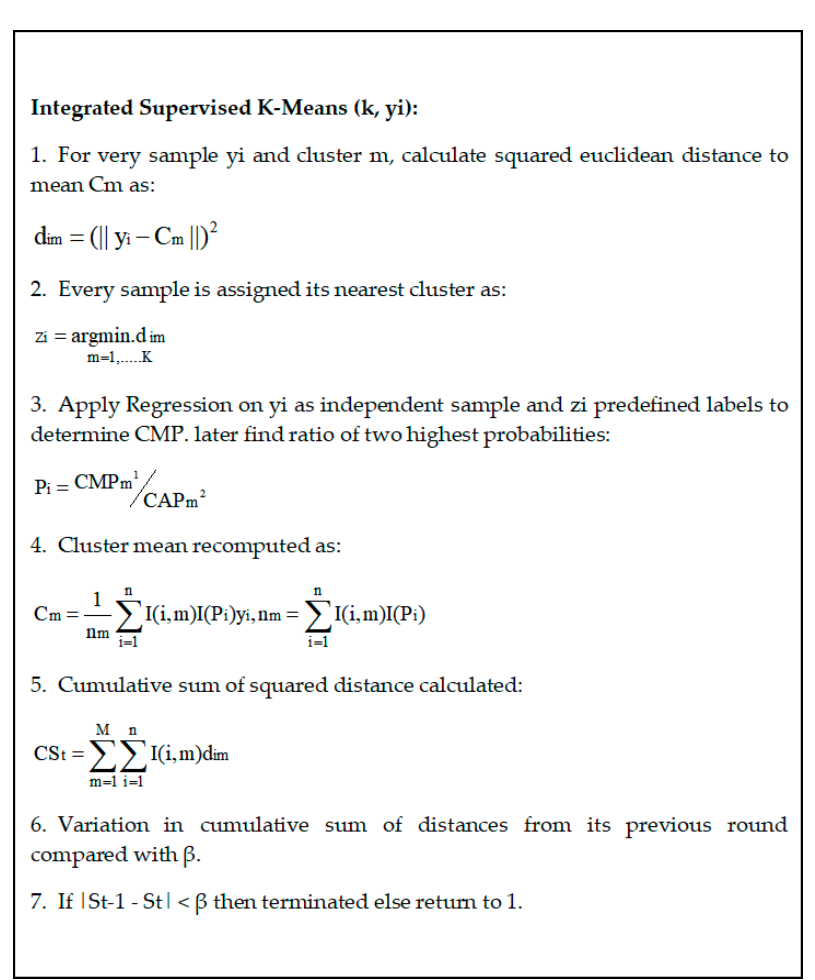
Figure 13. Pseudo code of Integrated Supervised K-Means.